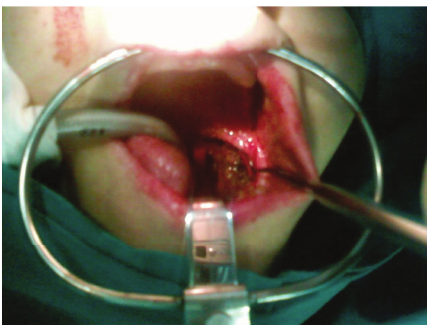
Figure 1: Exophytic, grayish, and ulcerated mass in the left tonsillar lodge (intraoperative image).